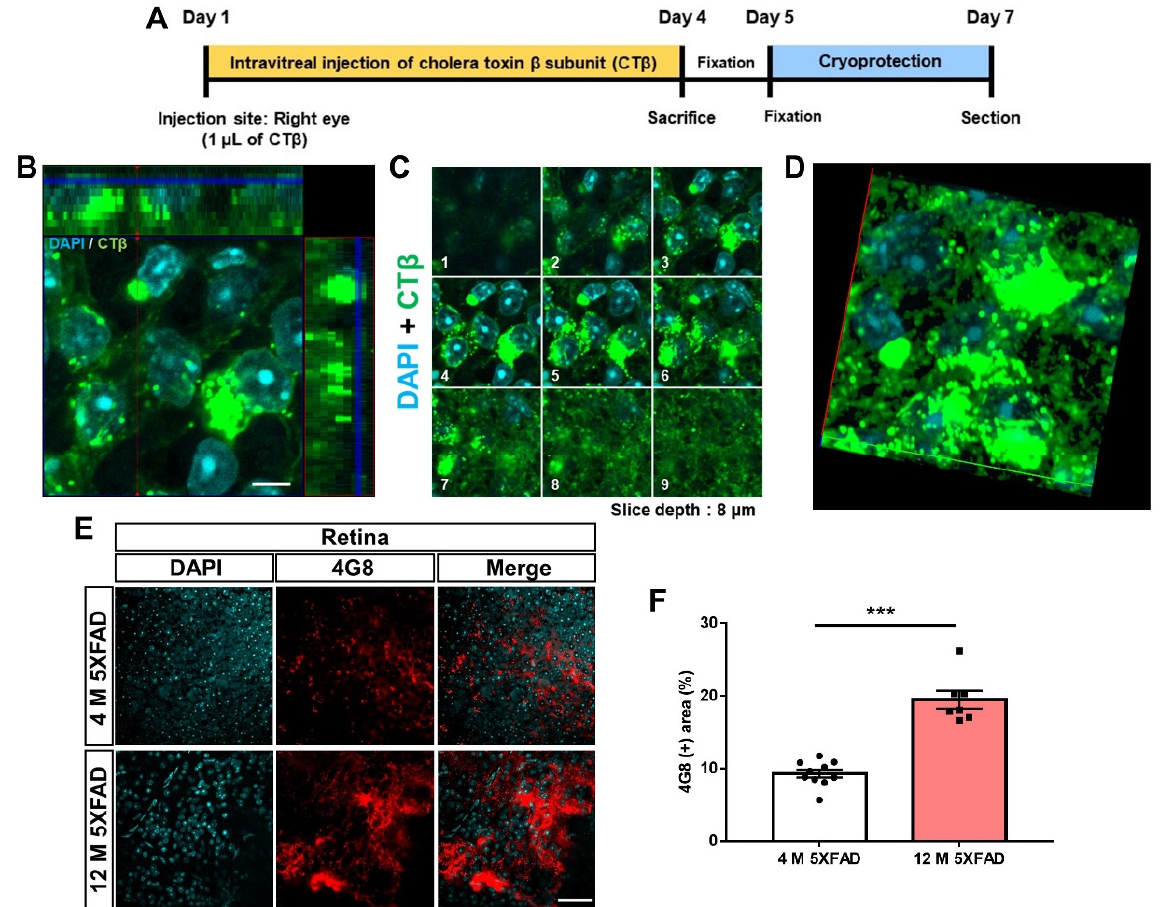
Figure 1. Validation of the application of cholera toxin β subunit (CT β ) and characterization of amyloid- β (A β ) deposition in the retina. ( A ) The schematic diagram shows the overall experimental design. ( B ) An orthogonal view of the z-stack images indicates that the CT β has an intracellular localization in retinal cells. The side and bottom panels, respectively, depict y–z and x–z cross-sectional images. Scale bar = 5 μ m. ( C ) Serial z-stack images consist of 9 sections at 1- μ m intervals. ( D ) The representative image shows a three-dimensional z-projection of the acquired stack. ( E ) The representative image shows A β accumulation in the retina by immunohistochemical staining with anti-4G8 antibody. Scale bar = 50 µ m. ( F ) The quantitative graph exhibits the area fraction of A β in the retina of 5XFAD mice (7–10 images of the retina wholemount sections were obtained from 5 mice in each group). Statistical analysis was conducted by an independent t -test. *** p < 0.001 indicate a significant difference.